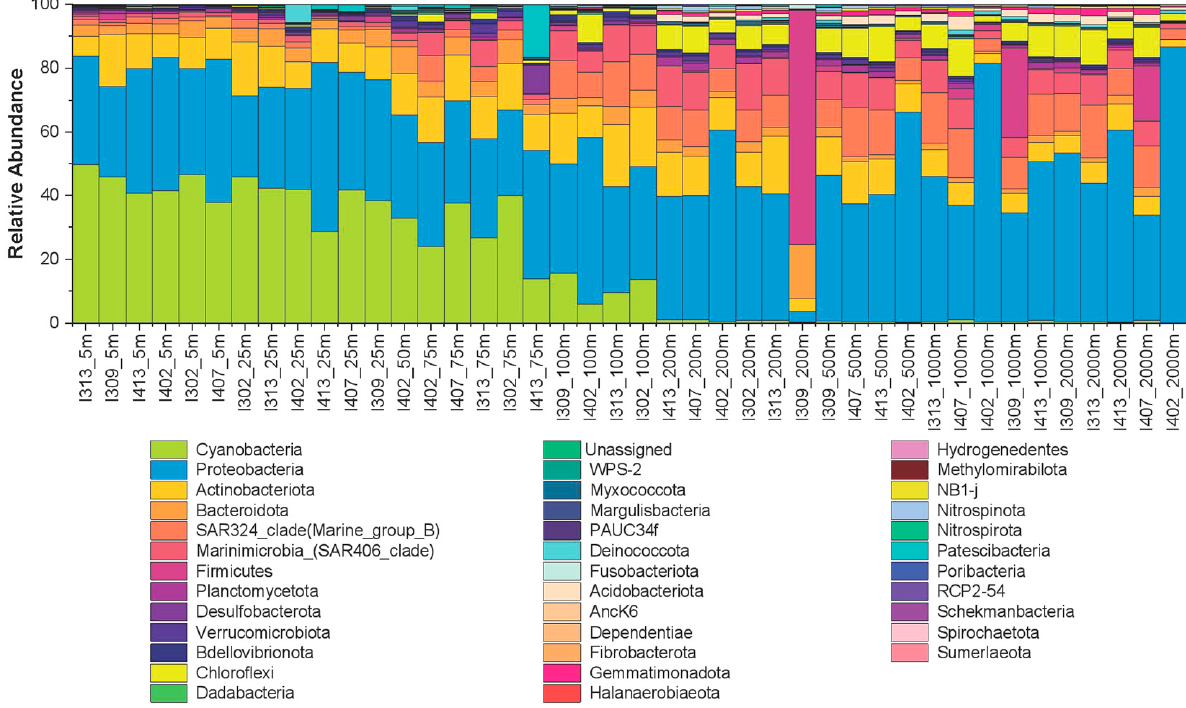
Figure 7. Bar plot showing bacterial community compositions (at phylum level) of different sampling stations.